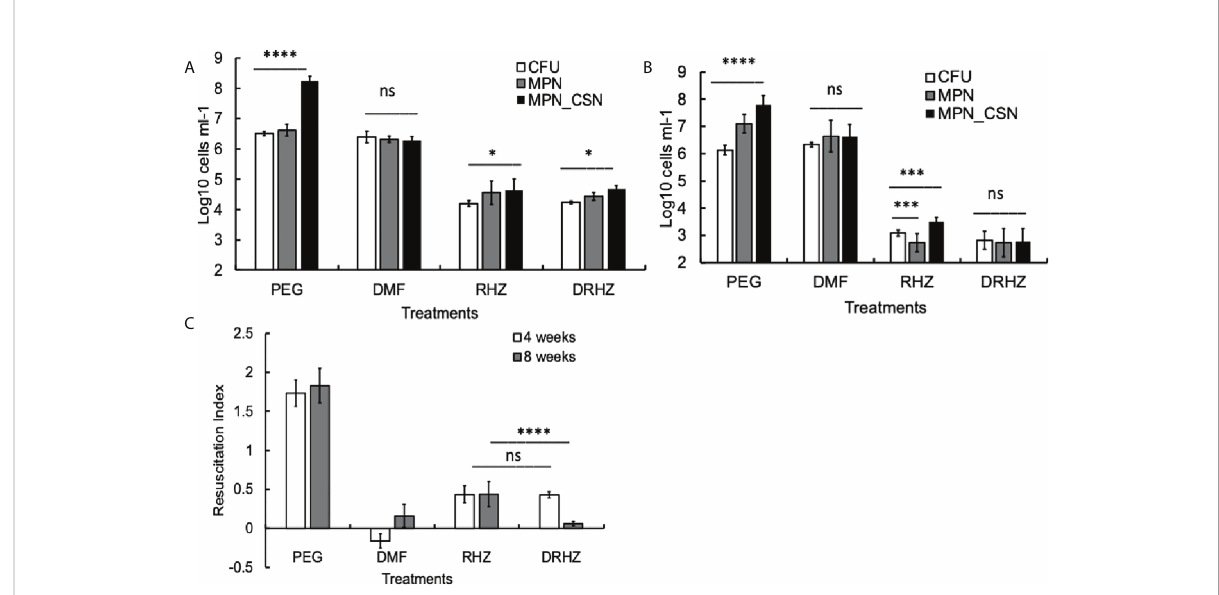
FIGURE 2 Effect of dimethyl fumarate (DMF), standard treatment and standard treatment with DMF on Mtb loads in the infected murine lungs after 4 (A) and 8 weeks of treatment (B) . Mice were infected intranasally as described in Methods and treatment began after 4 weeks of infection. Murine lung homogenates were used for CFU, MPN and MPN_CSN assays. (C) Resuscitation indices. Data shown as means ± STDV ( N = 7) (B) . The resuscitation indices were calculated using the following formula: RI= log 10 (MPN_CSN ml -1 ) – log 10 (CFU ml -1 ). PEG, control PEG 400 group; DMF, dimethyl fumarate group; RHZ, rifampicin, isoniazid and pyrazinamide group; and DRHZ, rifampicin, isoniazid, pyrazinamide and dimethyl fumarate group; Ns, non-signi fi cant; p > 0.05; * p < 0.05; *** p < 0.001; **** p < 0.0001 unpaired t -test.